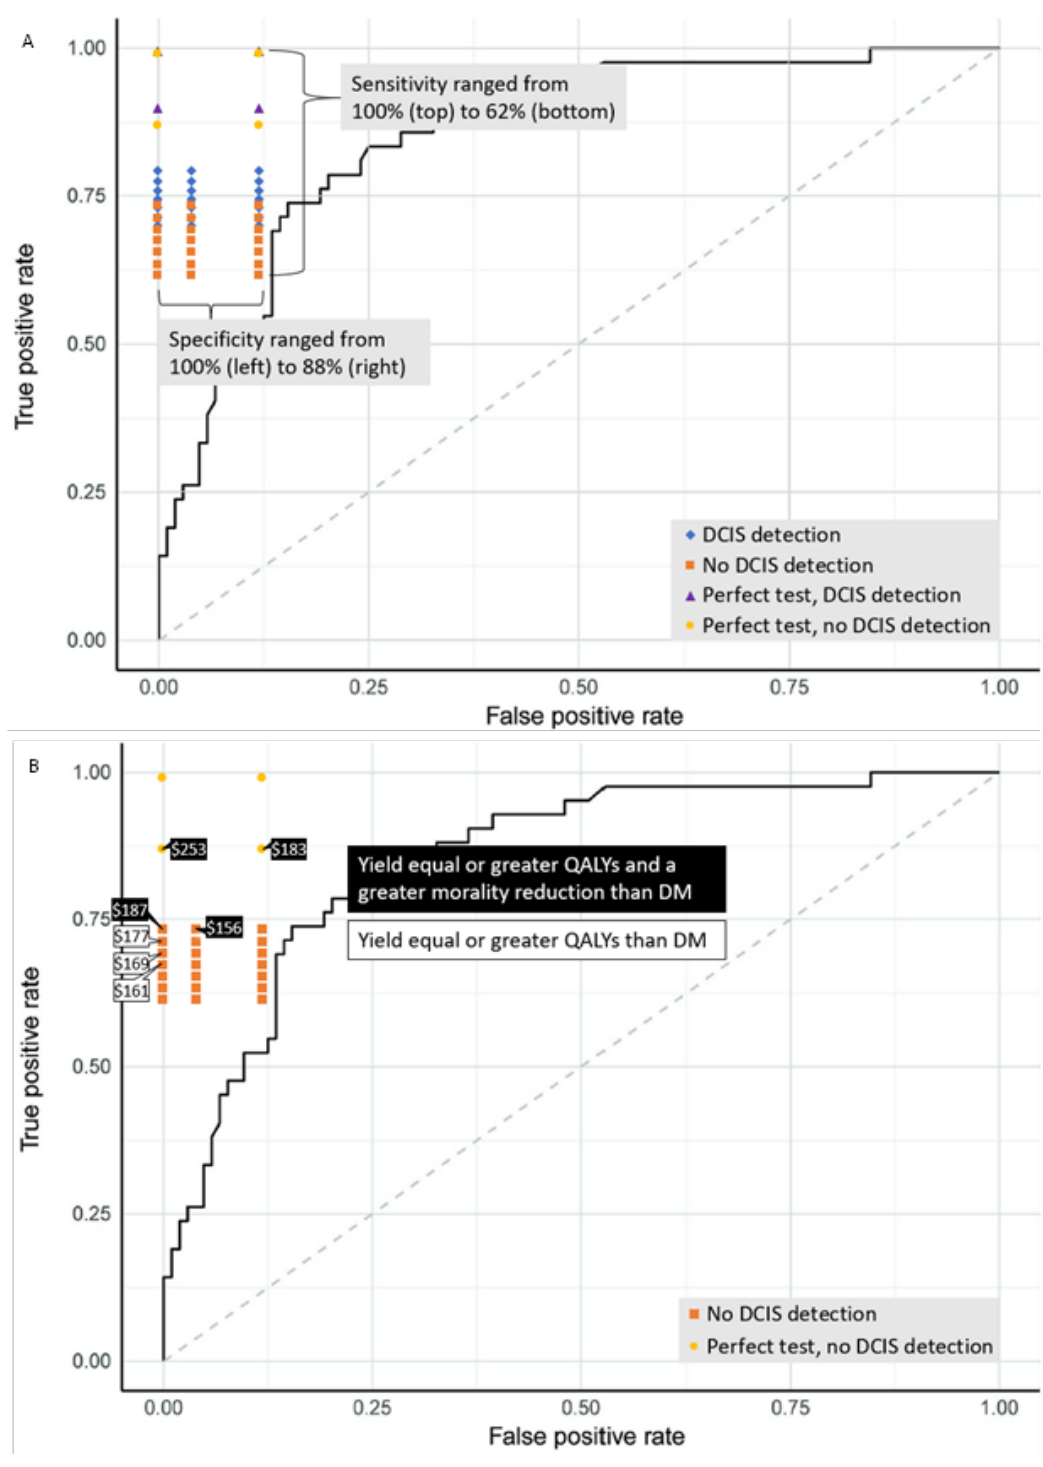
Figure 1. ROC curve of a CCGA breast cancer prediction model adapted from Ref. [21] with the TPR and FPR of the modeled liquid biopsies. ( A ) All modeled liquid biopsies in this study, ( B ) liquid biopsies that are unable to detect DCIS. The costs next to each liquid biopsy represent the maximum price for each liquid biopsy to be cost-effective compared to digital mammography at a threshold of USD 50,000. The filled boxes show the maximum prices where a similar or increased mortality reduction is gained compared to digital mammography screening. Abbreviations: DCIS, ductal carcinoma in situ; DM, digital mammography; TPR, true-positive rate; FPR, false-positive